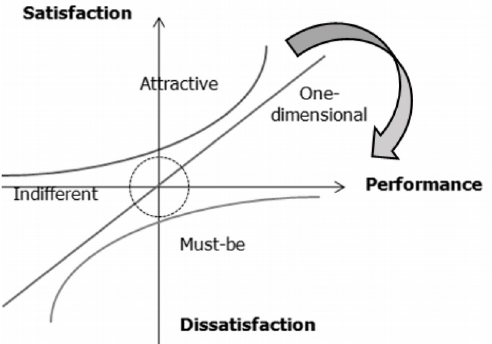
Figure 4. Quality attributes of Kano model and qualitative performance/satisfaction curves; the arrow represents the expected evolution of the